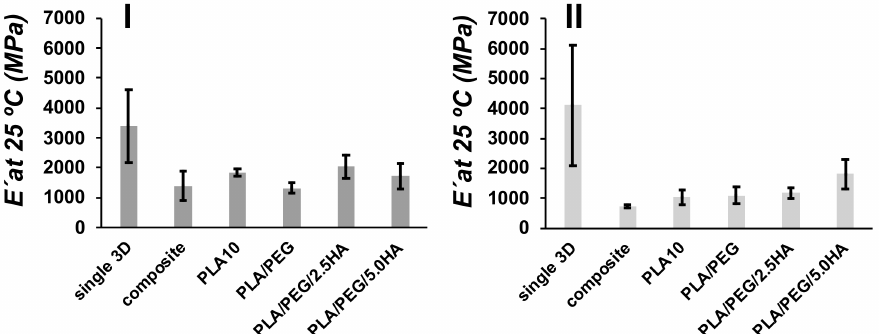
Figure 8. Comparison of E (cid:48) for ellipsoidal ( I ) and square ( II ) pore shape 3D-printed materials at 25 ◦ C for single 3D-printed pieces (single 3D), two 3D-printed pieces bonded (composite), and 3D-printed/electrospun composites (PLA10, PLA/PEG/, PLA/PEG/2.5HA, and